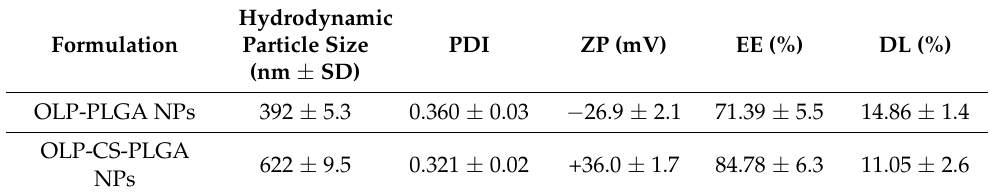
Table 2. Prepared NPs’ particle size, PDI, ZP, and encapsulation